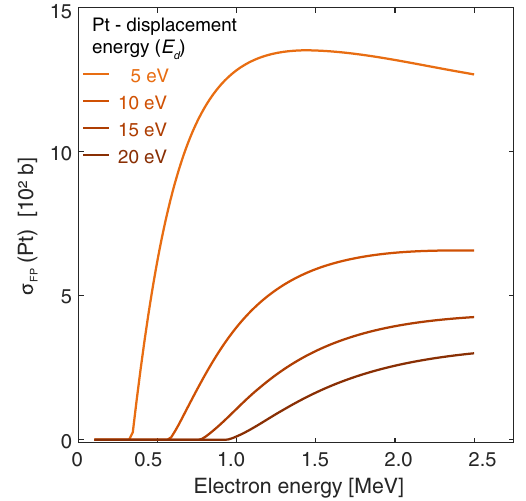
FIG. 7. Frenkel pair production cross section for Pt atoms as a function of electron energy, for a range of displacement energies.